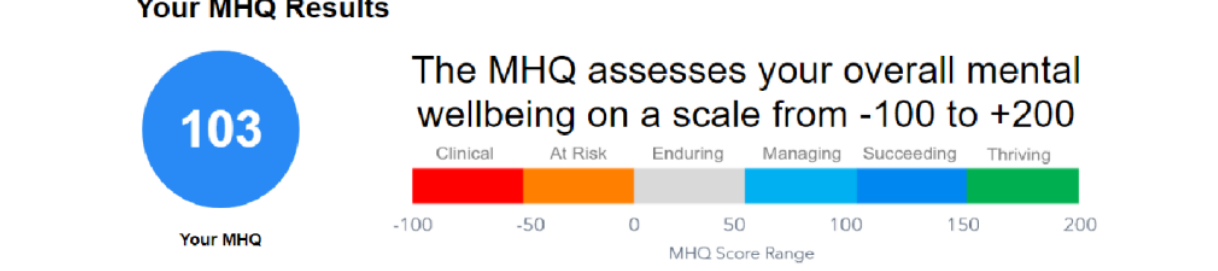
Figure 3. Extract of an example Mental Health Quotient results report. The report details the overall Mental Health Quotient score and recommendations based on that score. It also details each of the 6 subcategory scores as well as descriptions and recommendations based on each of those subcategory scores. MHQ: Mental Health